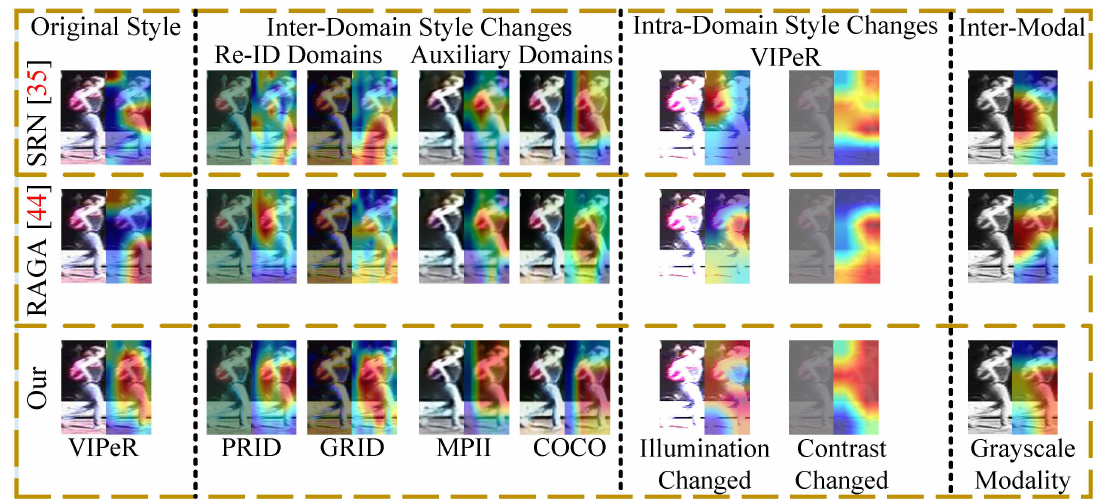
Figure 17. Comparison of Our Part Attention Maps with SRN [35] and RAGA [44].